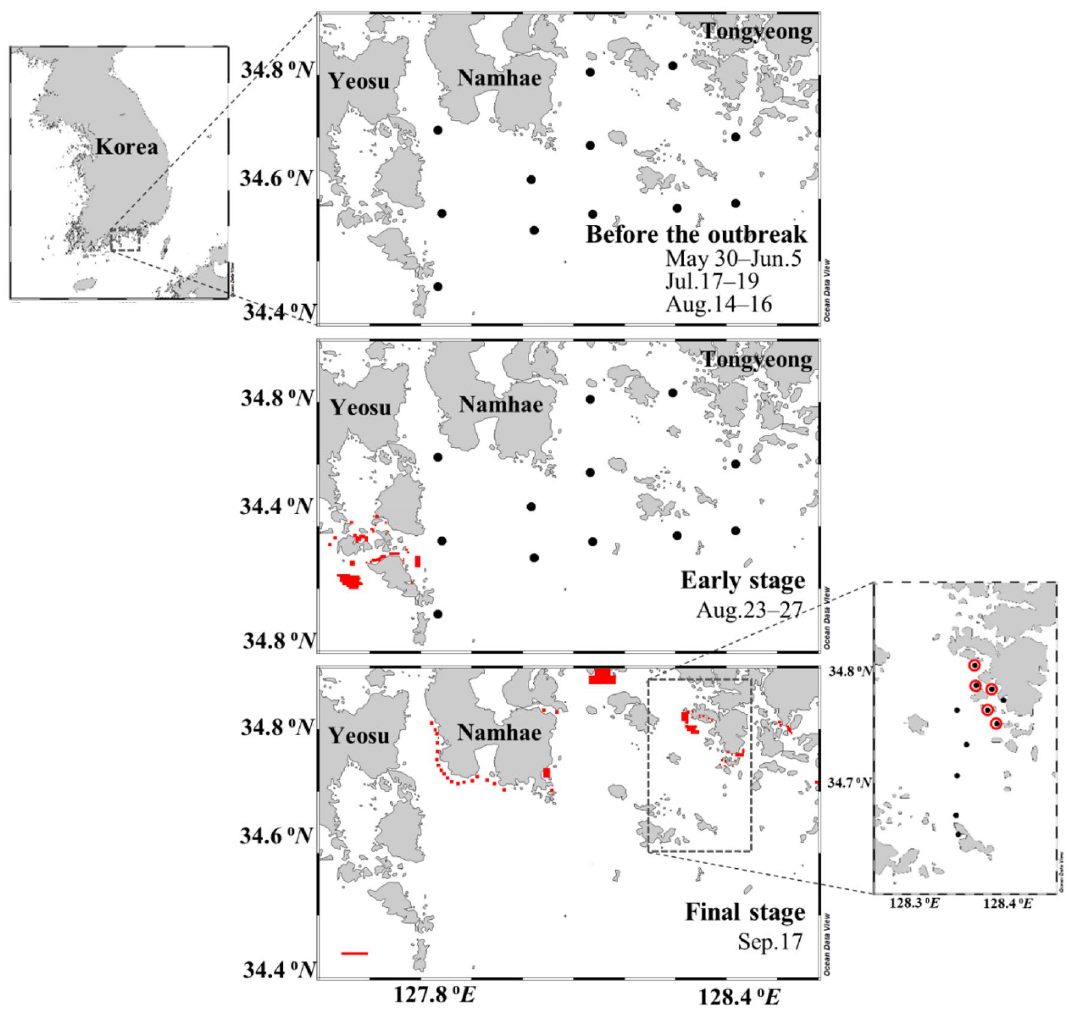
Figure 1. Map of the sampling stations (black circles) during May 30–June 5, July 17–19, and August 14–16 (before the outbreak of red tide), August 23–27 (the early stage of red tide), and September 17 (the final stage of red tide), 2019, in the southern coast of Korea. The red dots and the red circles represent the red tide patches (http:// www. nifs. go. kr/) 40